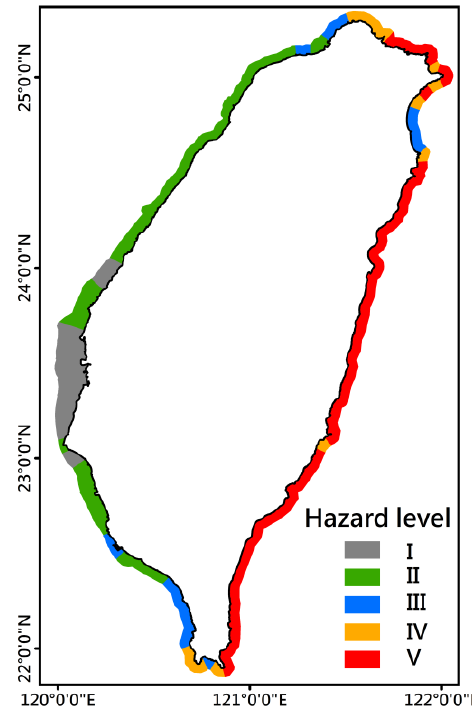
Figure 12. A comprehensive storm wave hazard map for SACZs.